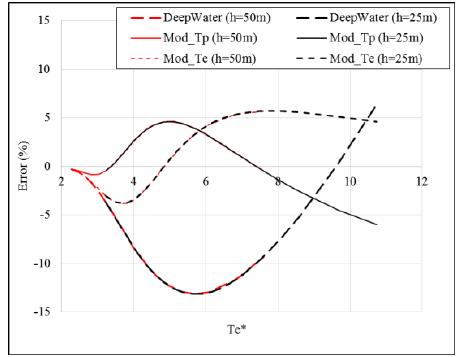
Figure 11. Errors for different water depth in non-dimensional wave periods.